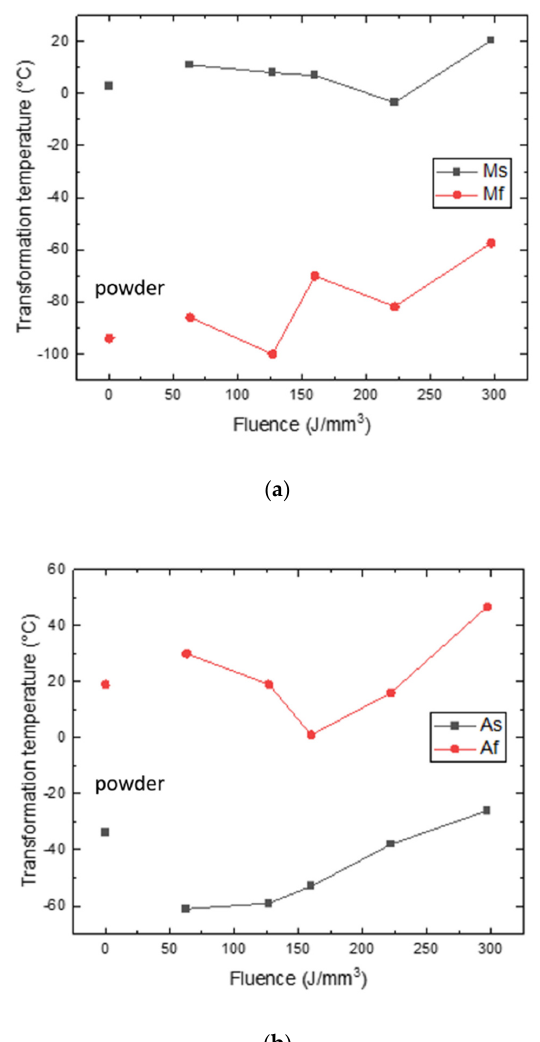
Figure 3. Evolution of the transformation temperatures of the direct ( a ) and reverse ( b ) martensitic transformation of the initial NiTi powder and the NiTi samples, produced at varying the laser fluence.